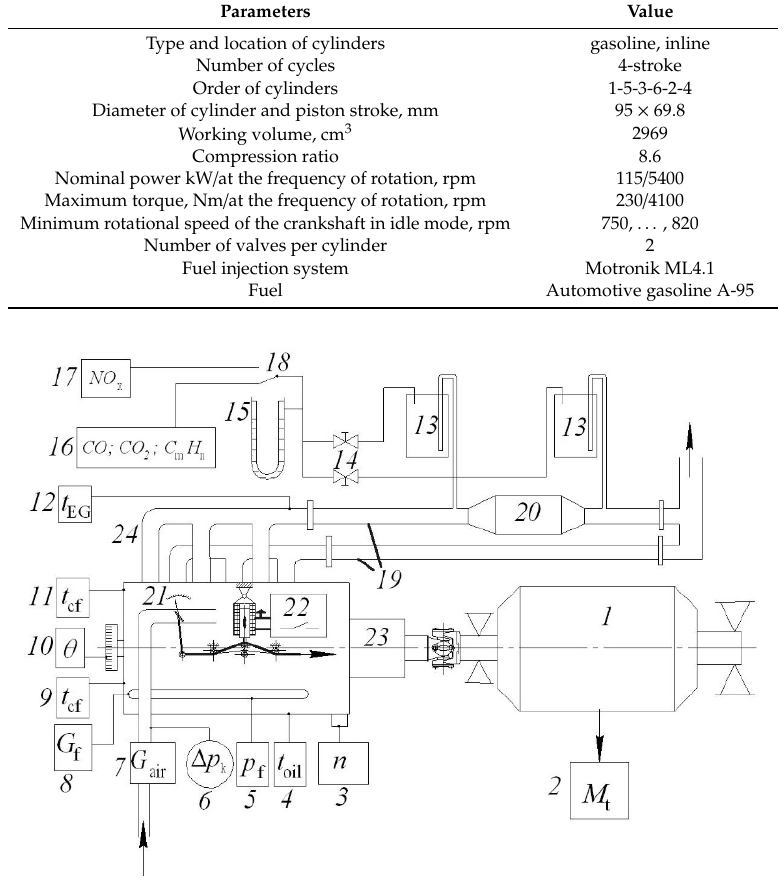
Table 1. Technical characteristics of the Opel C30 LE engine.